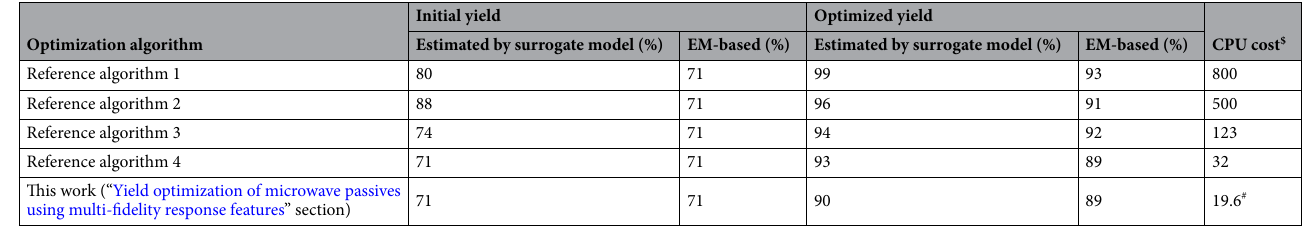
Table 6. Design centering results for Circuit III (Fig. 5c). $ Optimization cost in number of EM simulations of the considered circuit. # Equivalent number of high-fidelity EM simulations (actual number of analyzes was 6 high-fidelity and 30